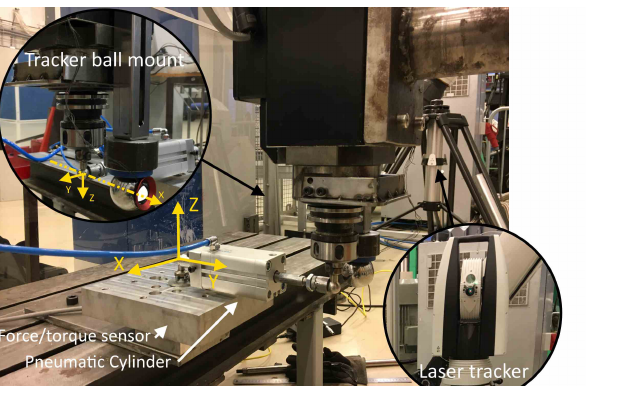
Figure 11: 6-DOF industrial robot: test setup using pneumatic cylinder, force sensor and laser tracker.